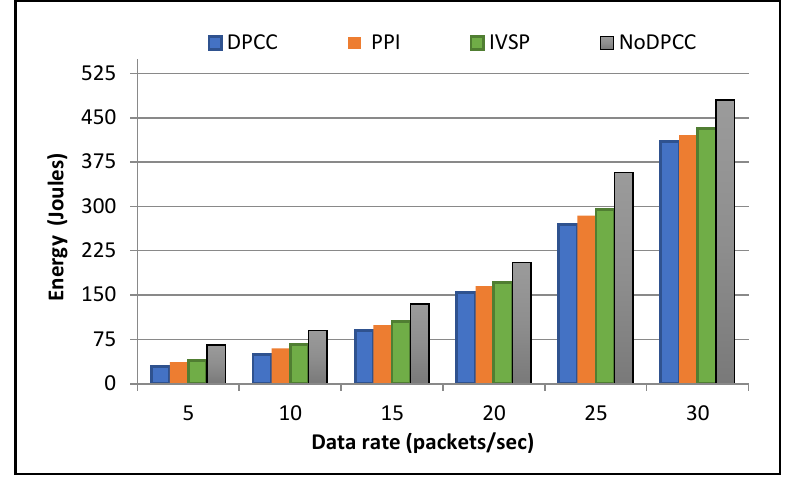
Figure 14. Energy consumption vs. data rate.